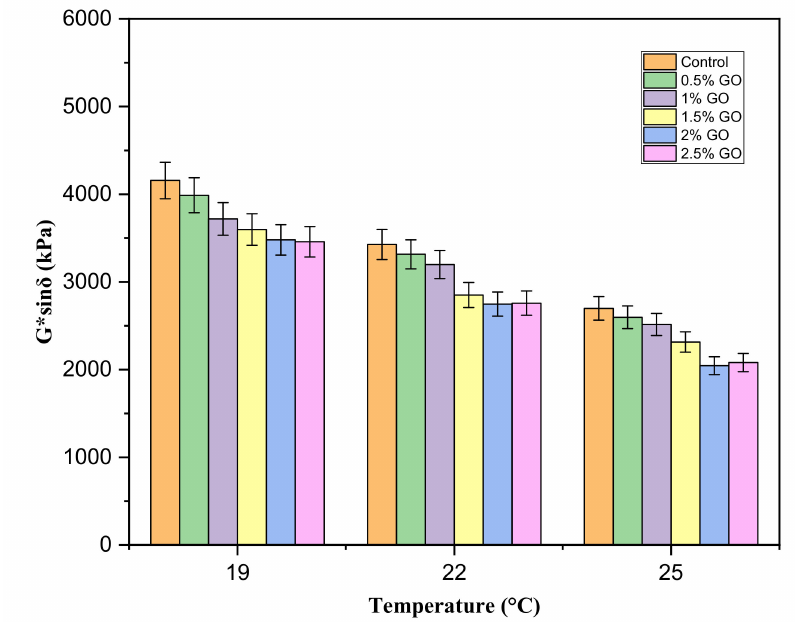
Figure 5. G*sin δ values of GO-modified binders at 19 ◦ C, 22 ◦ C, and 25 ◦